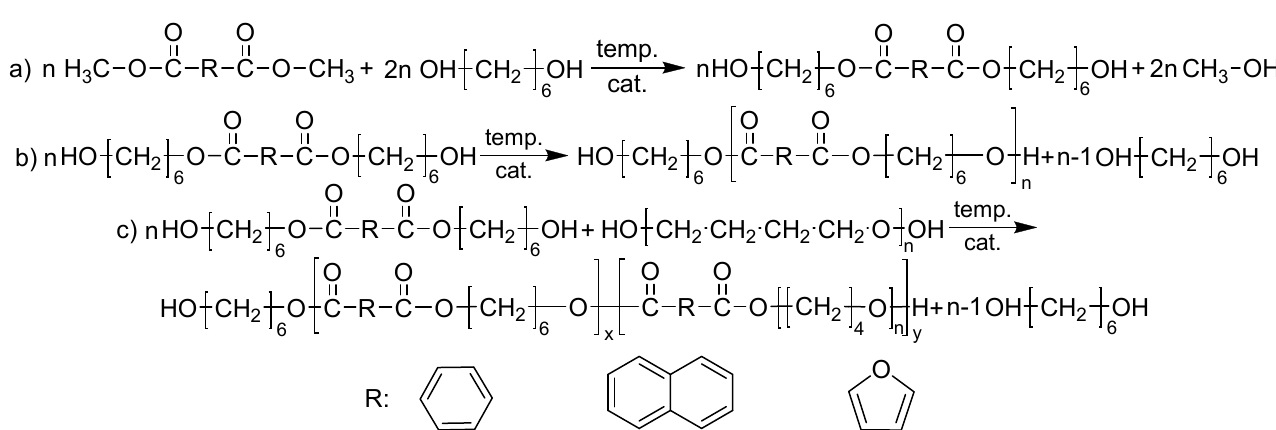
R: Figure 1. Synthesis reaction of ( a ) transesterification of polyesters and copoly(ether-ester)s; ( b ) polycondensation of polyesters; ( c ) polycondensation of copoly(ether-ester)s. Table 1. Temperatures and times used in the synthesis of polyesters and copoly(ether-ester)s. Transesterification Polycondensation Sample